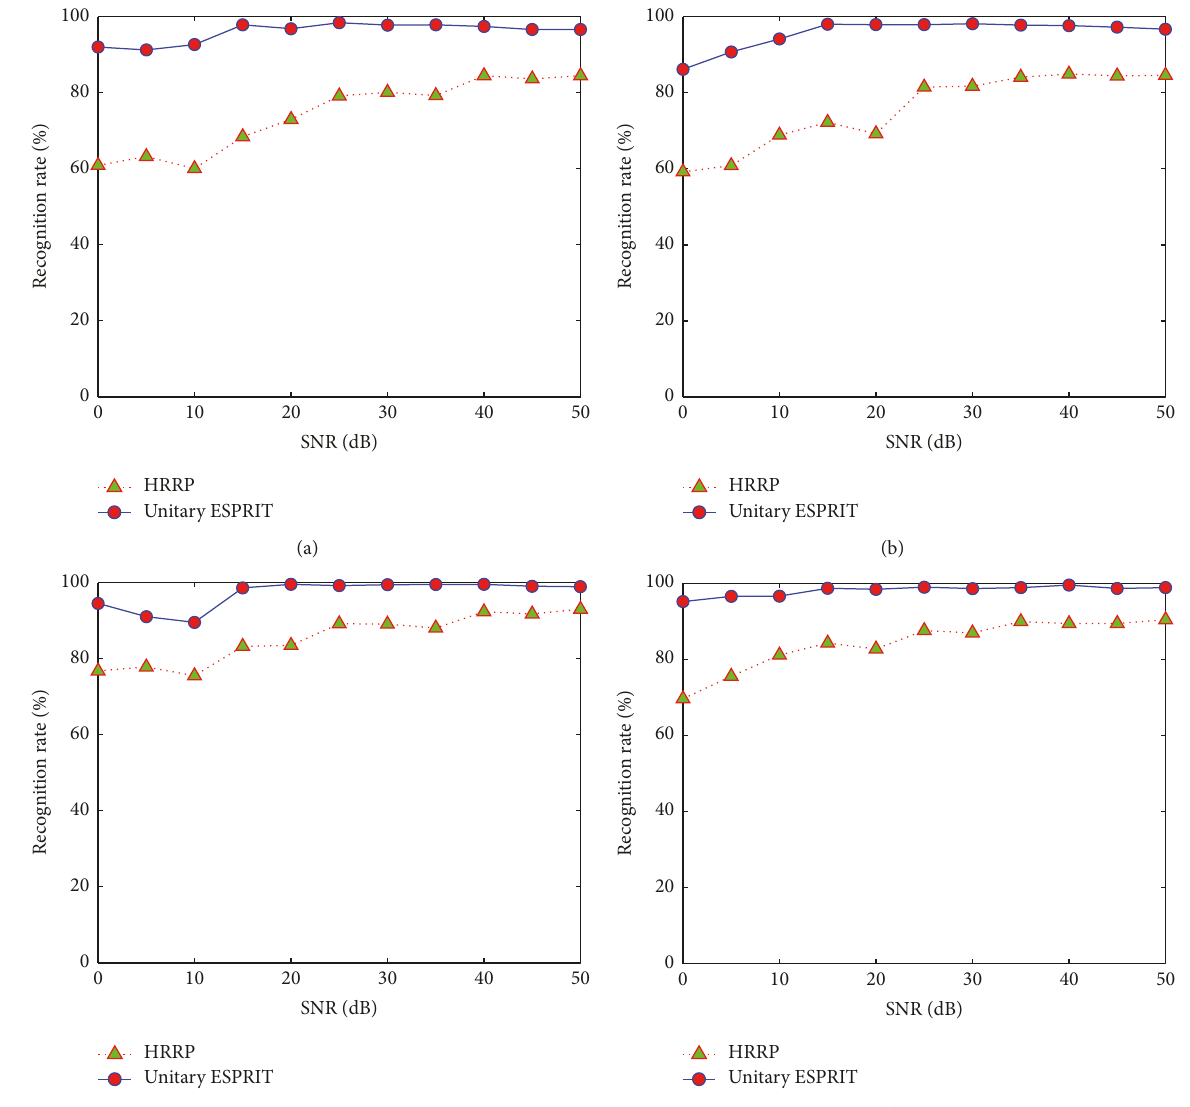
Figure 4: The average recognition rates of original method and our method for four targets versus SNR: (a) Target 1, (b) Target 2, (c) Target 3, and (d) Target